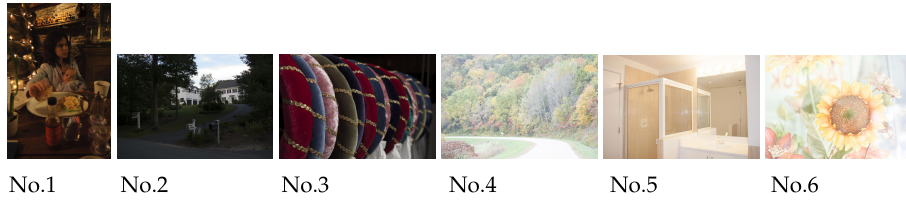
Figure 12. Color images selected from Afifi’s image dataset [17], which was originally rendered using raw images taken from the MIT-Adobe FiveK dataset [18]. Nos. 1 to 3 are underexposed images, and Nos. 4 to 6 are overexposed ones.